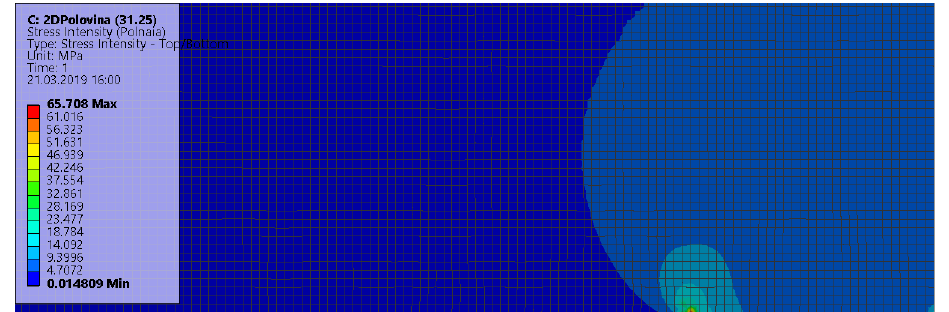
Fig. 13. Distribution of stress intensity σ i on the bottom surface of the deep beam y =0(0 ADH ) in 2D